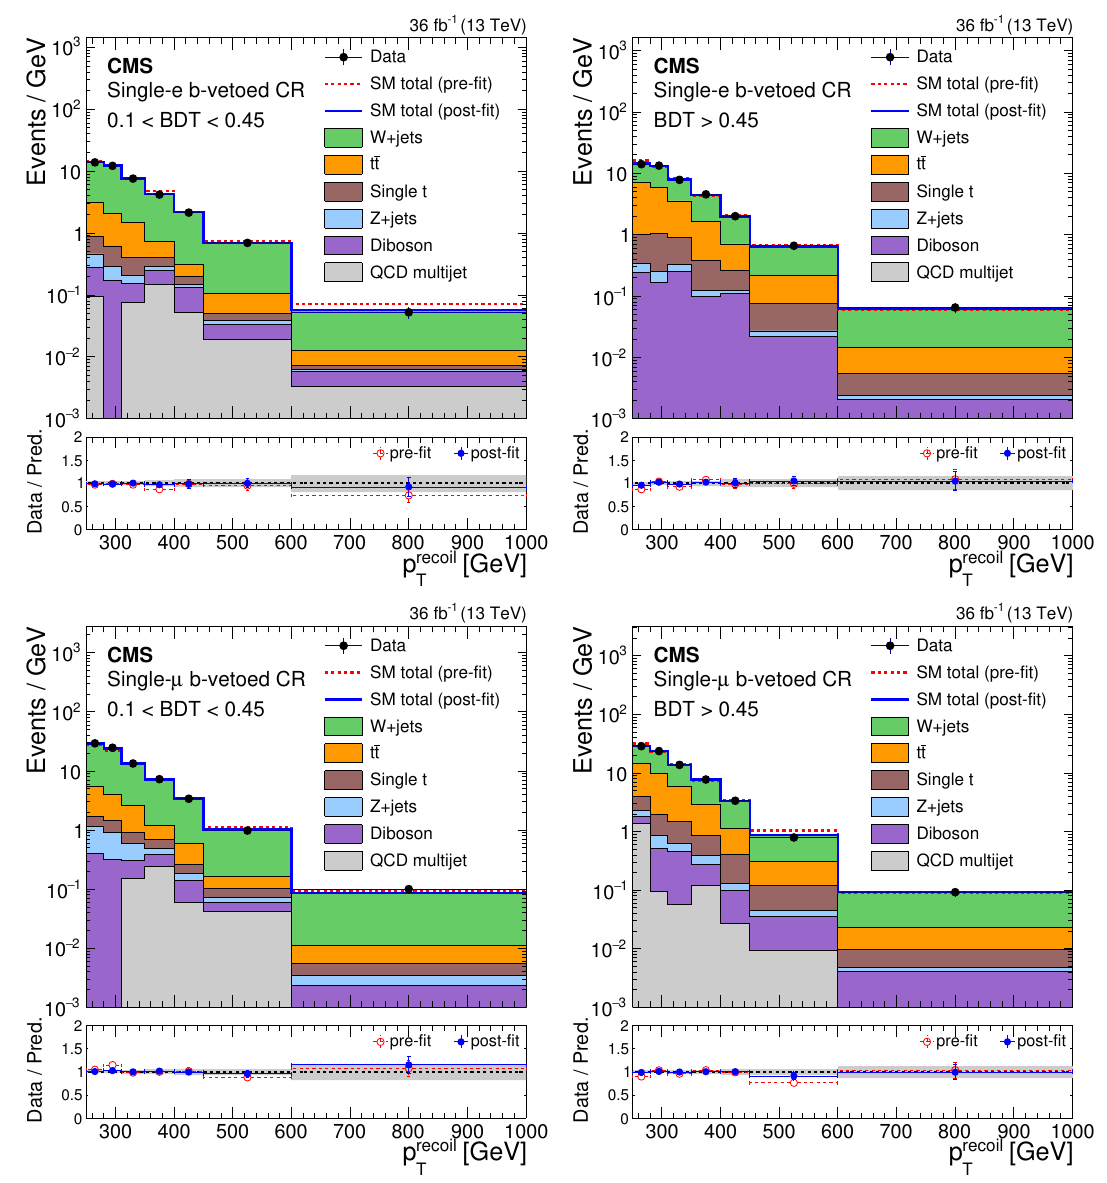
Figure 6 . Comparison between data and SM predictions in the b-vetoed single lepton control regions before and after performing the simultaneous (cid:12)t to the di(cid:11)erent control regions and signal region. Each bin shows the event yields divided by the width of the bin. The upper row of (cid:12)gures corresponds to the single electron b-vetoed control region, and lower row to the single muon b-vetoed control region. The left (right) column of (cid:12)gures corresponds to the loose (tight) category of the control regions. The blue solid line represents the sum of the SM contributions normalized to their (cid:12)tted yields. The red dashed line represents the sum of the SM contributions normalized to the prediction. The stacked histograms show the individual (cid:12)tted SM contributions. The lower panel of each (cid:12)gure shows the ratio of data to (cid:12)tted prediction. The gray band on the ratio indicates the one standard deviation uncertainty on the prediction after propagating all the systematic uncertainties and their correlations in the